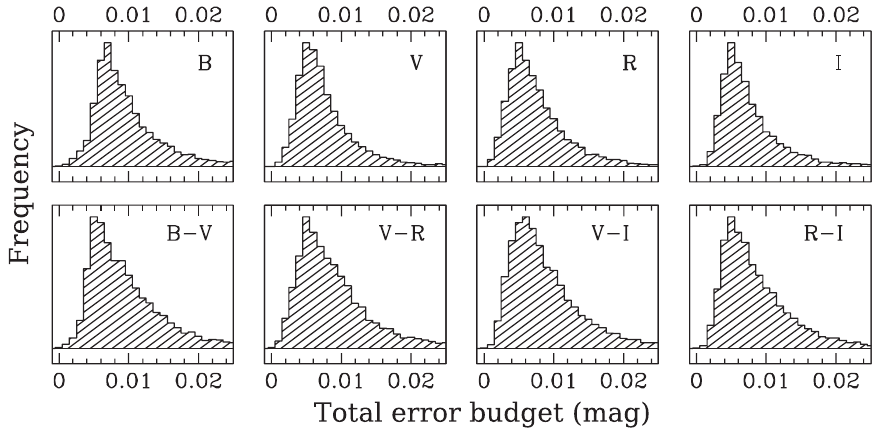
Fig. 8. Cumulative distribution, for passbands and colors, of the total error budget (expressed in magnitudes) for ANS observations of symbiotic